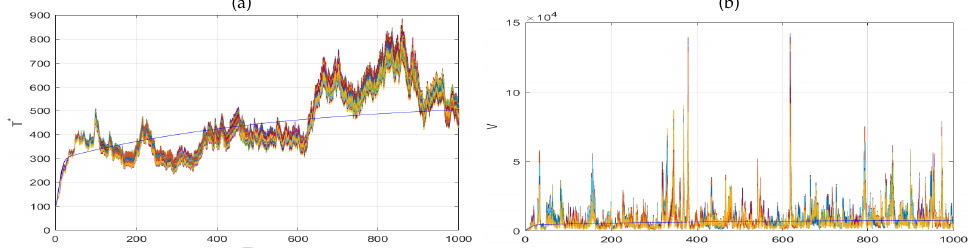
Figure 2. The effects of white noise and telegraphic noise on virus evolution in model (2) with R s ≈ 23.6278 > 1, where 500 trajectories have the same initial value: ( a ) trajectories of T ∗ ( t ) ; 0 ( b ) trajectories of V ( t ) . Here, blue curve is without stochastic perturbation, other color oscillation curves are with stochastic